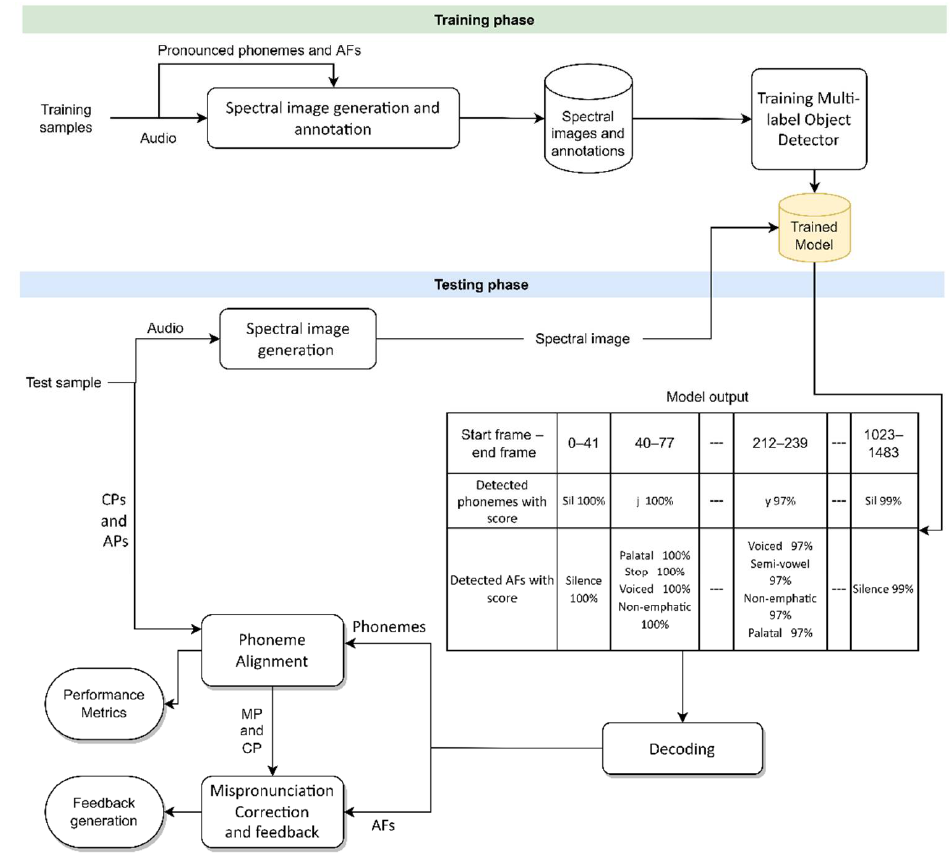
Figure 2. General overview of the MDD-Object system. CPs: canonical phonemes; APs: annotated phonemes; MP: mispronounced phonemes.